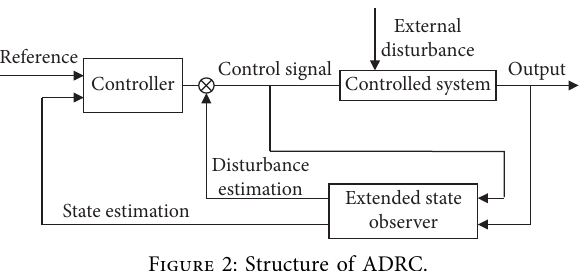
Figure 2: Structure of ADRC.